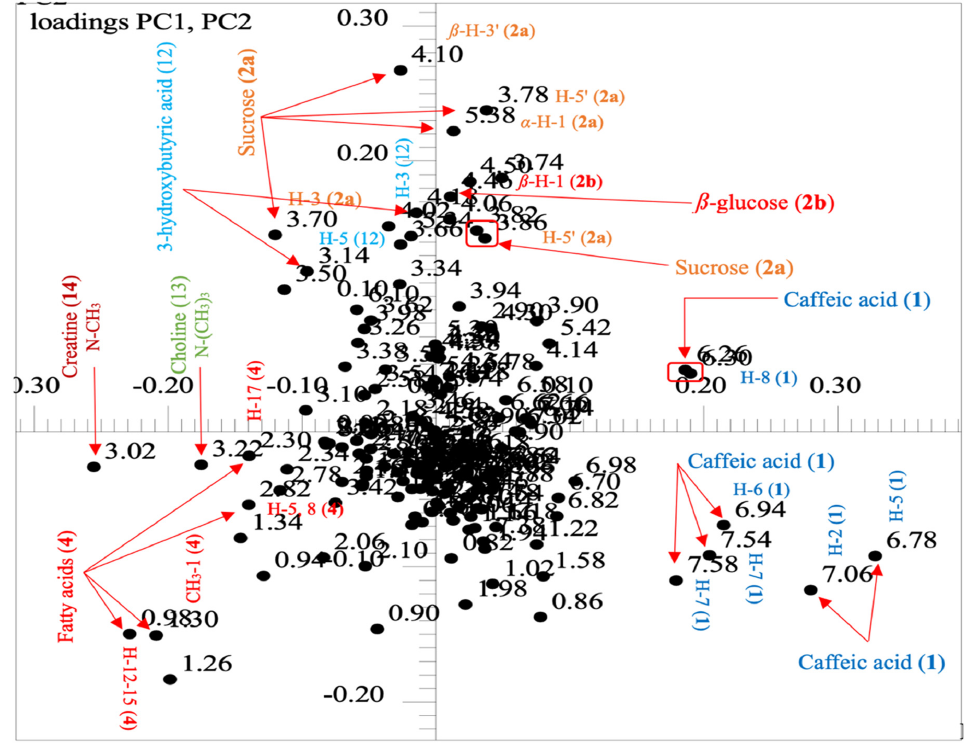
Figure 12. Loadings plot showing all chemical features for each group revealed in the scores plot, obtained with spectral widths of δ 10.0 to 0.60 utilizing the bucket size δ 0.04 and pareto-scaled PC1 (50.25%) vs. PC2 (32.09%) of 28 × 174 data matrix that revealed a net variance of 82.34%.